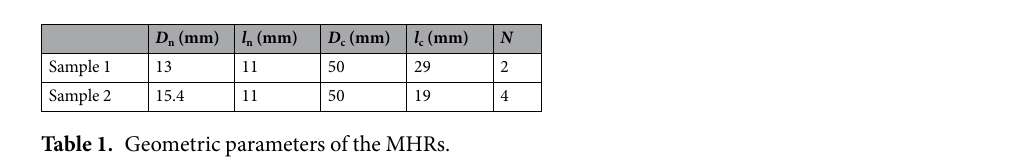
Figure 1. 2D cross-section and 3D view of (a) the THR and (b) the MHR (a quarter of the complete structure). The insets show the corresponding effective electric circuit models. (c) The transmittances of the MHR with N = 2 (the orange solid line) and the THR (the olive dashed line) for reference. (d) The effective bulk modulus of the MHR.